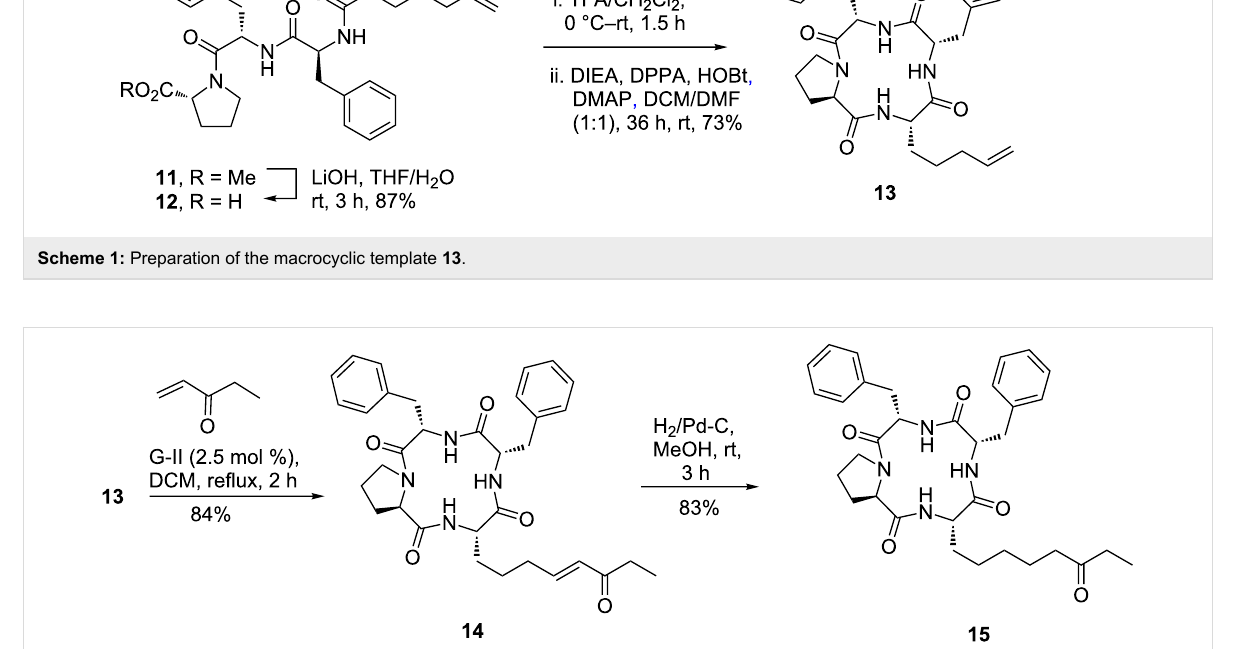
Scheme 2: Synthesis of nor-FR225497 ( 15